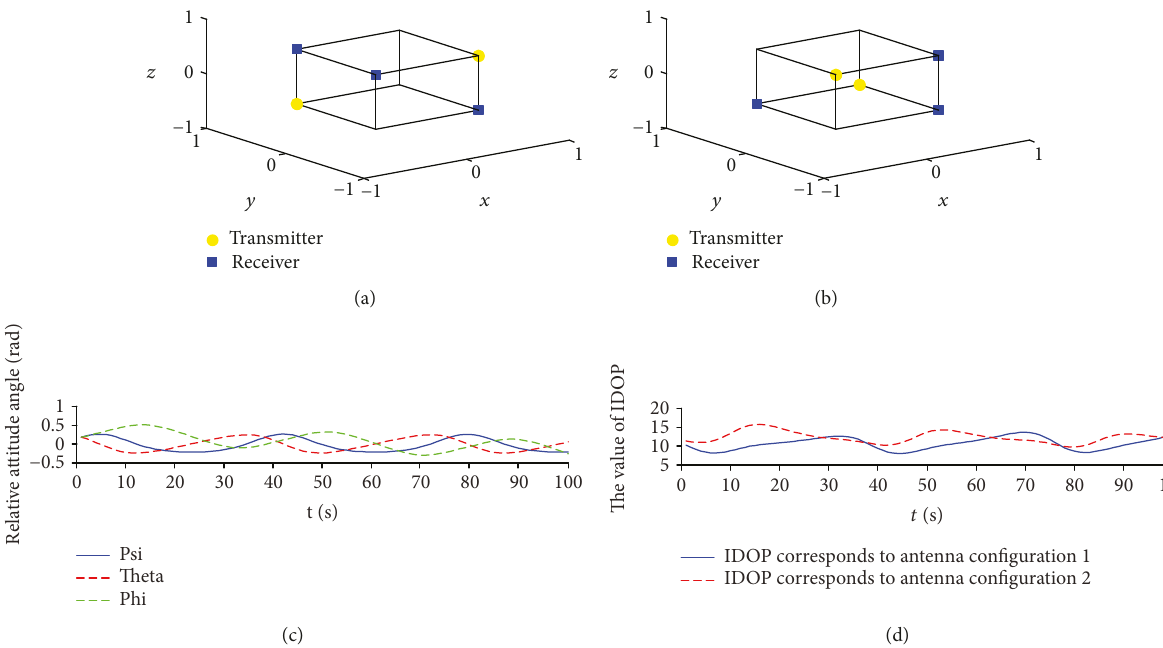
Figure 2: IDOP with the change of relative attitude of the intersatellite: (a) the optimal antenna con fi guration 1 when satellite relative attitudes psi=0.174 (rad), theta=0.174 (rad), phi =0.174 (rad); (b) the optimal antenna con fi guration 2 when satellite relative attitudes psi=0.042 (rad), theta=0.236 (rad), phi= − 0.277 (rad); (c) trajectory of satellite relative attitude; (d) IDOPs in the case of satellite relative attitude changing.